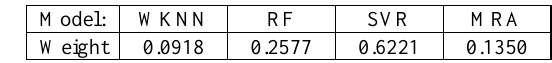
Table 3. Weights for the basic